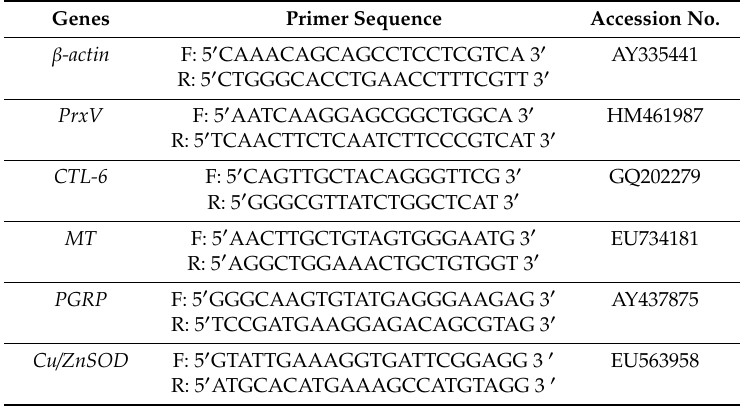
Table 1. Primers used for the analysis of mRNA expression by